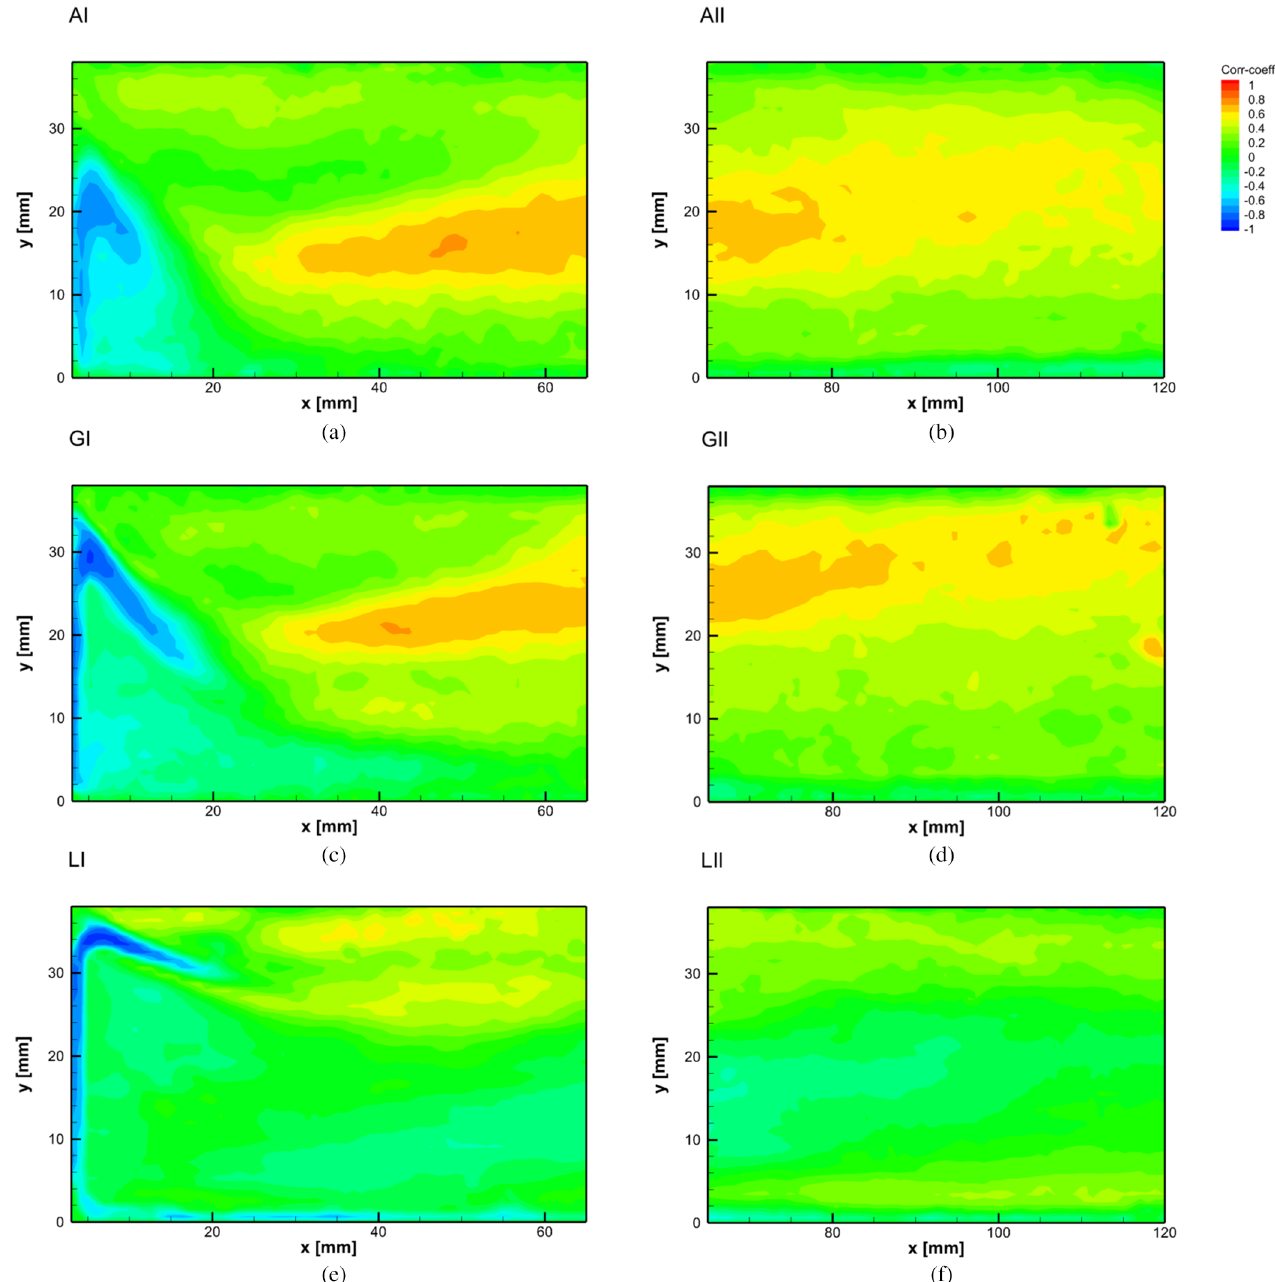
Fig. 9. Velocity components correlation coef fi cient distributions in the branches A, G and L, respectively: (a) AI, (b) AII, (c) GI, (d) GII, (e) LI and (f)